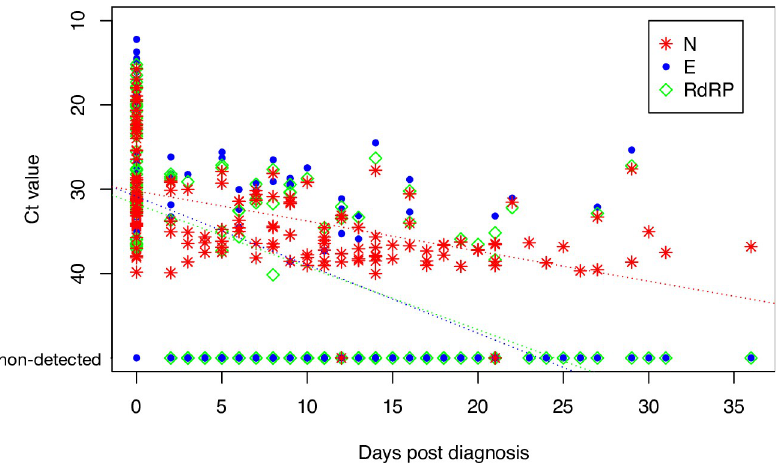
Fig 1. Ct values per days post diagnosis. Ct values of N, E and RdRp reactions, obtained using the Allplex 2019-nCoV assay in patient serial samples. Negative reactions (Ct value > 40) are denoted. Dotted lines represent linear regression per each gene, with the coefficient of determination (r2) and T-test p value (p) denoted in the figure legend. The insert summarizes the days post diagnosis in which each gene is detected (Ct values > 40 not included).